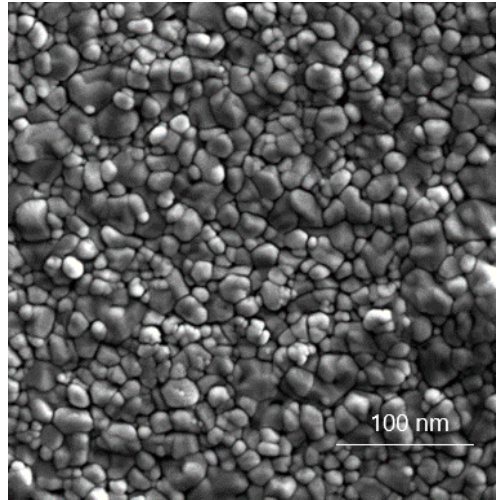
Figure 1. X-ray di ff ractogram of TiO2 from the commercial sunscreen with an average particle size of 43 nm (determined by XRD); inner image – XRD of rutile standard (R) and anatase standard (A).